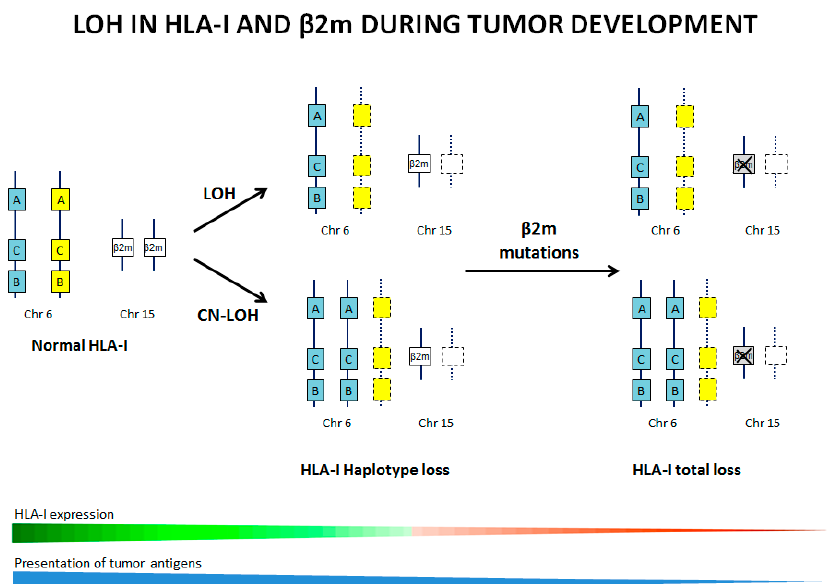
Figure 4. Schematic illustration of the accumulation of genetic alterations in chromosomes 6 and 15 (LOH, CN-LOH and β 2-microglobuline mutations) accompanied by the decrease in tumor HLA-I expression and antigen presentation during the natural history of tumor development.